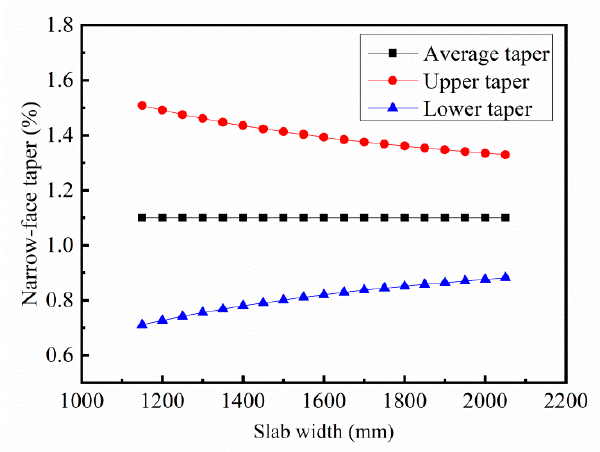
Figure 15. Relationship between the width and taper.